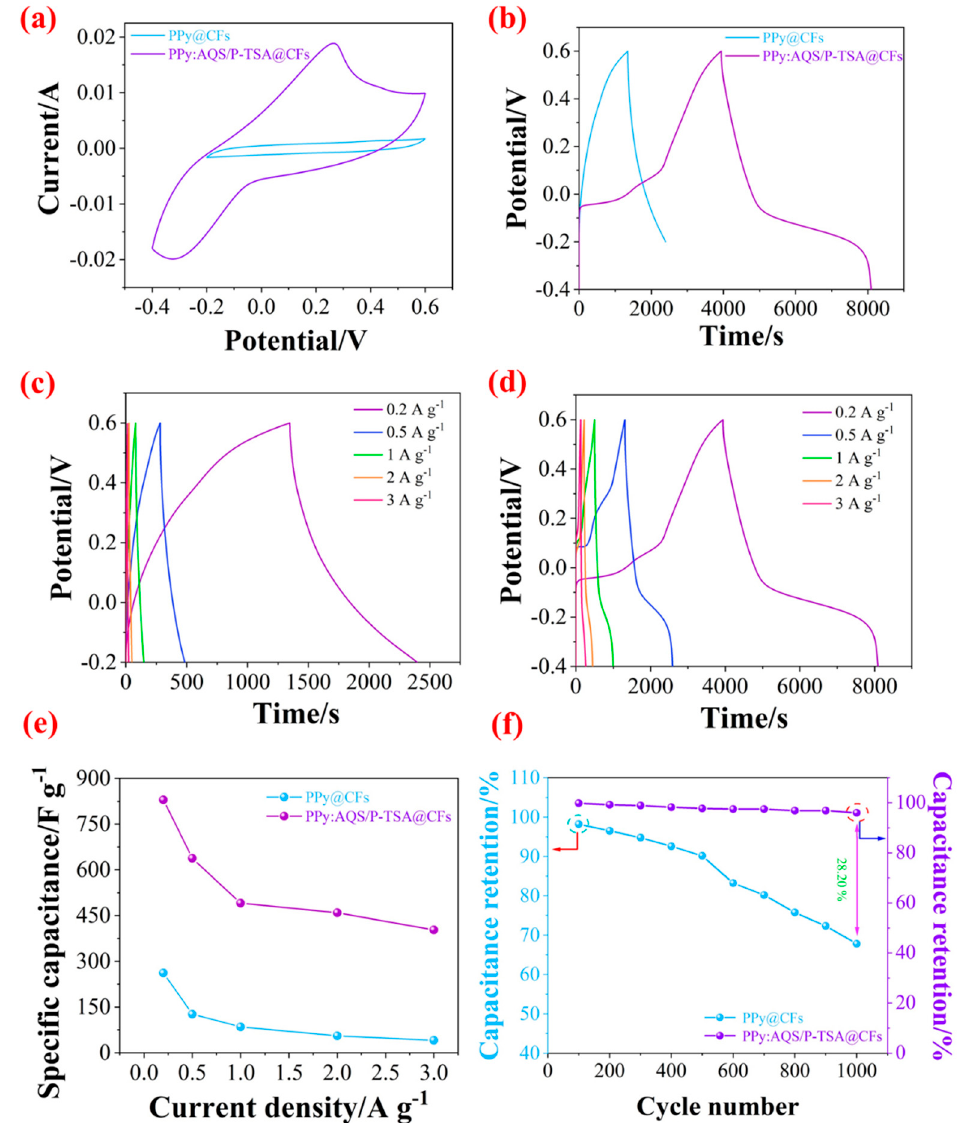
Figure 5. ( a ) CV curves of PPy@CFs and PPy:AQS/p-TSA@CFs electrode materials at a scan rate of 5 mV s − 1 ; ( b ) GCD curves of PPy@CFs and PPy:AQS/p-TSA@CFs electrode materials at a current density of 0.2 A g − 1 ; ( c , d ) GCD curves of PPy@CFs and PPy:AQS/p-TSA@CFs electrode materials at different current densities (0.2, 0.5, 1, 2, and 3 A g − 1 ); ( e ) specific capacitance of PPy@CFs and PPy:AQS/p-TSA@CFs electrode materials at different current densities (0.2, 0.5, 1, 2, and 3 A g − 1 ); and ( f ) capacitance retention of PPy@CFs and PPy:AQS/p-TSA@CFs electrode materials in the 1000 cyclic charging/discharging process.